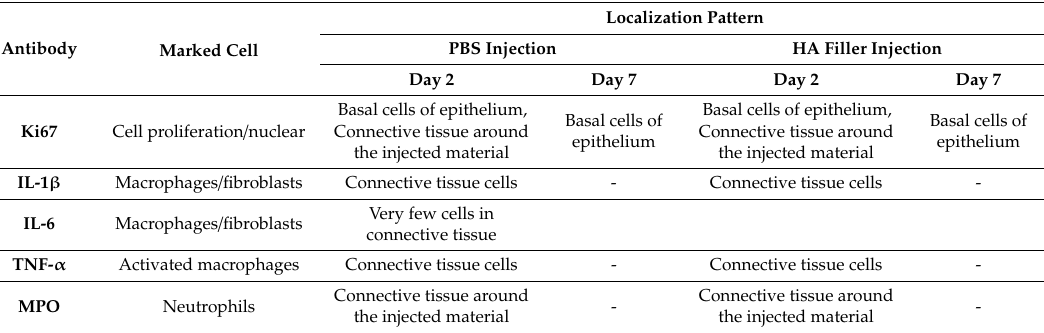
Table 1. The immunolocalization pattern of inflammatory cytokines in the interdental papilla loss site injected with phosphate-bu ff ered saline (PBS) or hyaluronic acid (HA) filler. Localization Pattern PBS Antibody Marked Cell